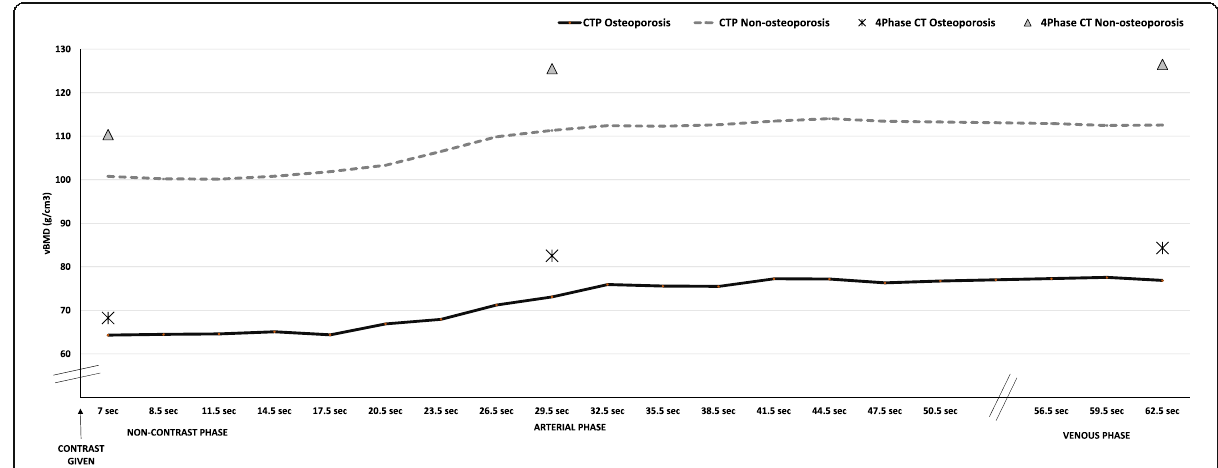
Fig. 4 Volume bone mineral density (vBMD) value of osteoporotic (black line) and non-osteoporotic (dotted line) vertebrae in computed tomography (CT) perfusion imaging over time as well as vBMD values from osteoporotic (stars) and non-osteoporotic (triangles) vertebrae in 4-phase CT over time.